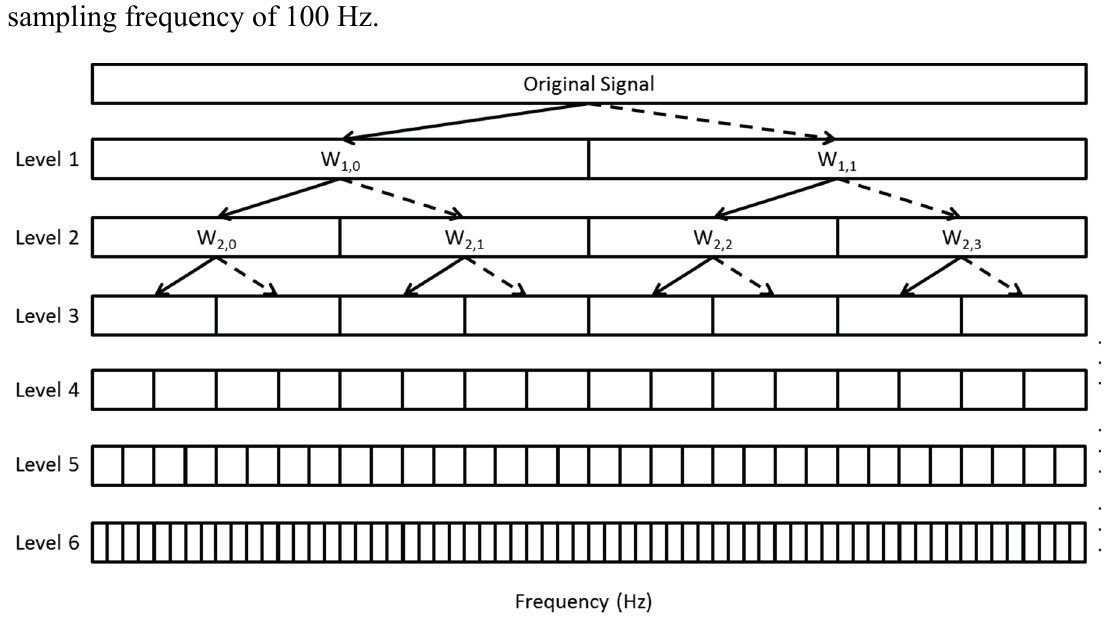
Figure 2. Wavelet packet transform (WPT) decomposed from one to six levels. The original signal is transformed into each frequency component (cid:1849) by detail coefficients (solid lines) (cid:3037),(cid:3041) and scaling coefficients (dotted lines). The frequency indexes range from 0 to 2 (cid:3037) − 1 for zero to the Nyquist frequency (50 Hz (Equation (4)) for WPT in this study) with an original sampling frequency of 100 Hz.